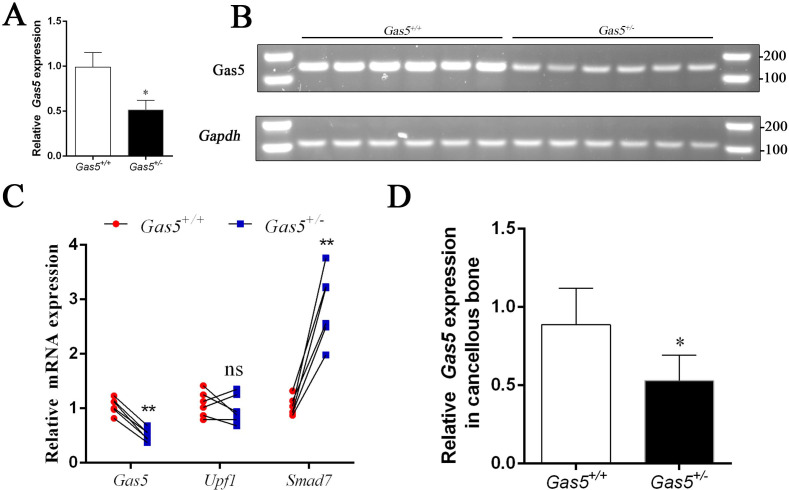
Relative gene expression in mouse.(A, B) Relative Gas5 expression in the tails of Gas5+/+ (n = 6) and Gas5+/- (n = 6) mice analyzed by qRT-PCR and agarose gel electrophoresis. (C) Relative mRNA expression of Gas5, Upf1 and Smad7 in BMSC of Gas5+/- and WT mice (n = 6). (D) The mRNA level of Gas5 in cancellous bone of Gas5+/-mice and WT mice.